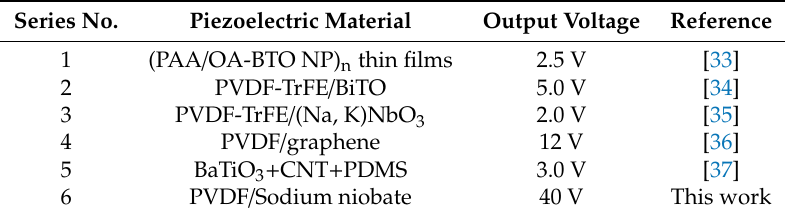
Table 1. Comparison of the output voltage of various piezoceramic embedded in the polymer matrix. Series No.